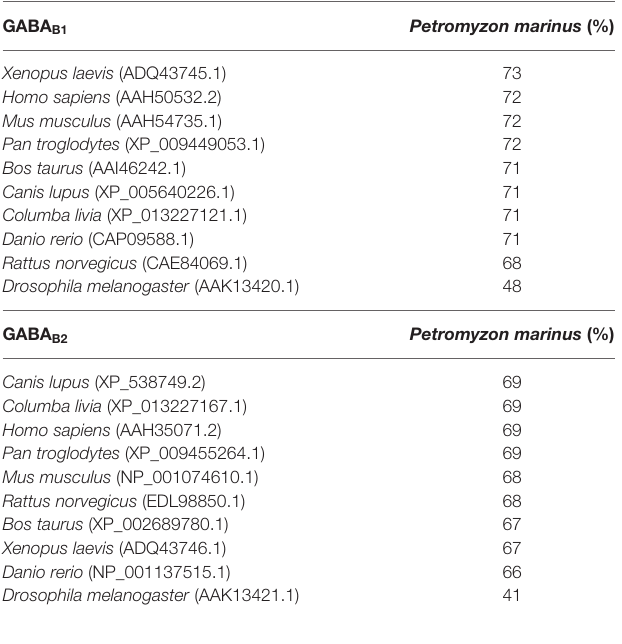
TABLE 1 | Percentage of homology between the partial amino acid sequences of the sea lamprey GABA B subunits and the amino acid sequences of GABA B subunits of different vertebrate and invertebrate species.